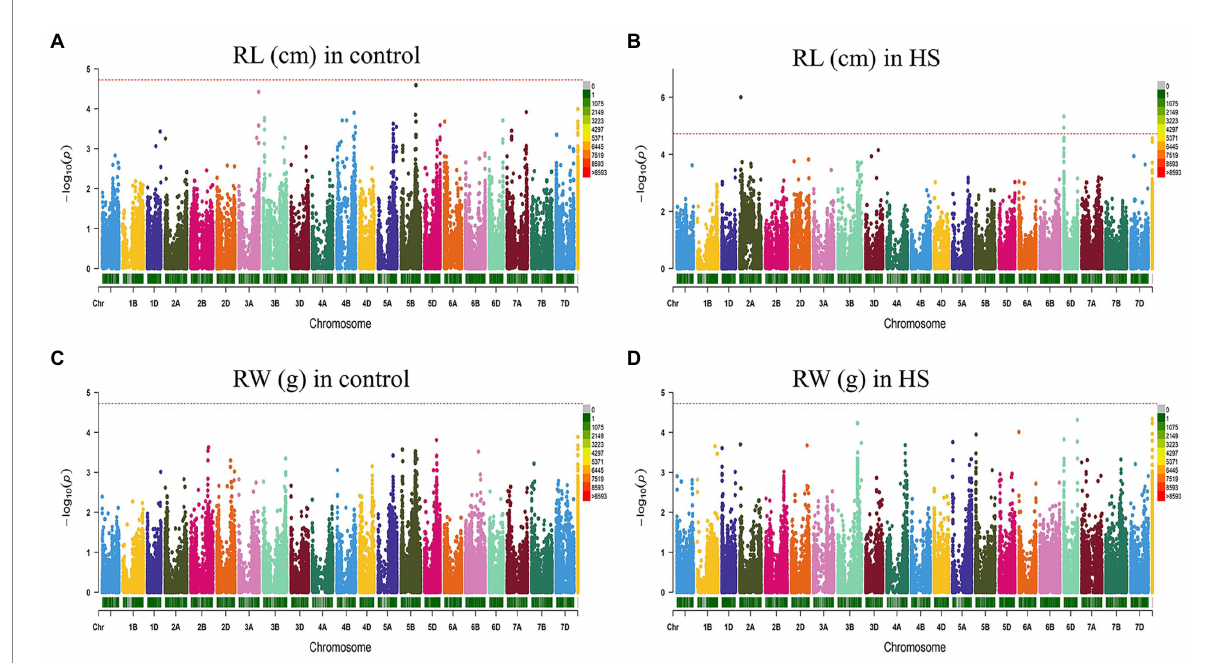
FIGURE 3 Manhattan plot showing density of SNP markers associated with root length (A) control condition; (B) HS condition, root weight (C) control condition; (D) HS